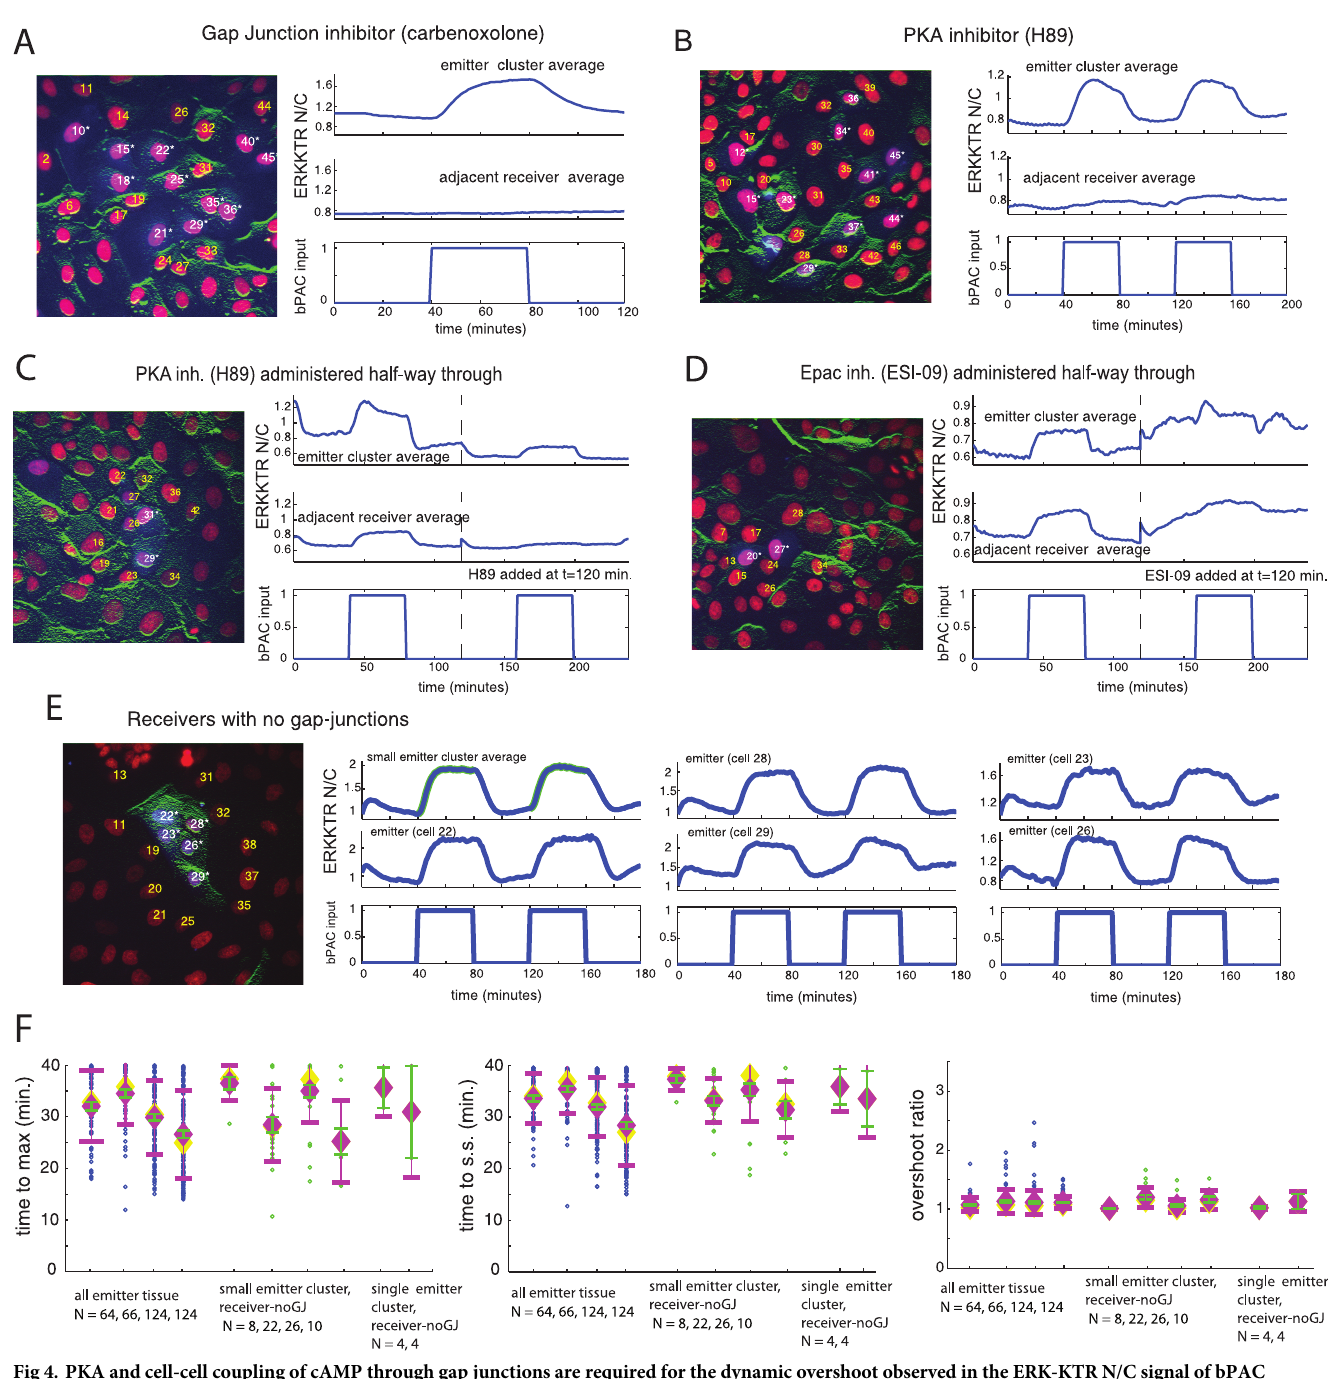
Fig 4. PKA and cell-cell coupling of cAMP through gap junctions are required for the dynamic overshoot observed in the ERK-KTR N/C signal of bPAC induced emitters from small emitter clusters. Single cell ERK-KTR N/C signals in all-emitter monolayers are representative of the dynamics due to intracellular regulation . (A-D) Left image depicts emitter cluster (emitter cells—purple nuclei with white labels, adjacent receiver cells—red nuclei with yellow labels). Right Panel: top plot: average small-emitter-cluster ERK-KTR N/C signal, middle plot: average adjacent receivers ERK-KTR N/C signal, bottom plot: bPAC input pulse sequence (max amplitude). (A) Small emitter cluster experiment with gap-junction inhibition (carbenoxolone): Emitter-receiver coupling is lost. (B) Small emitter cluster experiment with PKA inhibition (H89, 10 μ M): Emitter-receiver coupling is inhibited. (C and D) Testing how Epac and PKA inhibitors affect ERK under bPAC activation for small-emitter cluster experiments. Cells are imaged during a pulsed bPAC input sequence (40 minutes off, 40 minutes on, 40 minutes off). An inhibitor is then added and the bPAC input sequence is repeated while the same cells are imaged. (C) Small emitter cluster driven by a sequence of bPAC input pulses. PKA inhibitor (H89, 10 μ M) is added half way through. (D) Small emitter cluster driven by a sequence of bPAC input pulses. Epac inhibitor (ESI-09) is added half way through. (E) Experimental results for small emitter cluster surrounded by receivers that do not form gap junctions (MDCKII cells). Left panel: Image of small emitter